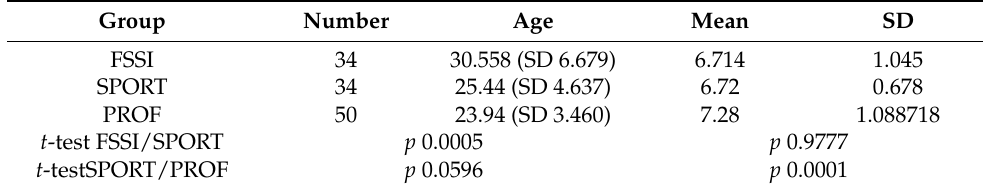
Table 2. Average values and standard deviations for the Corsi’s test score in NORM and FSSI with equivalent athletic skill level. Group